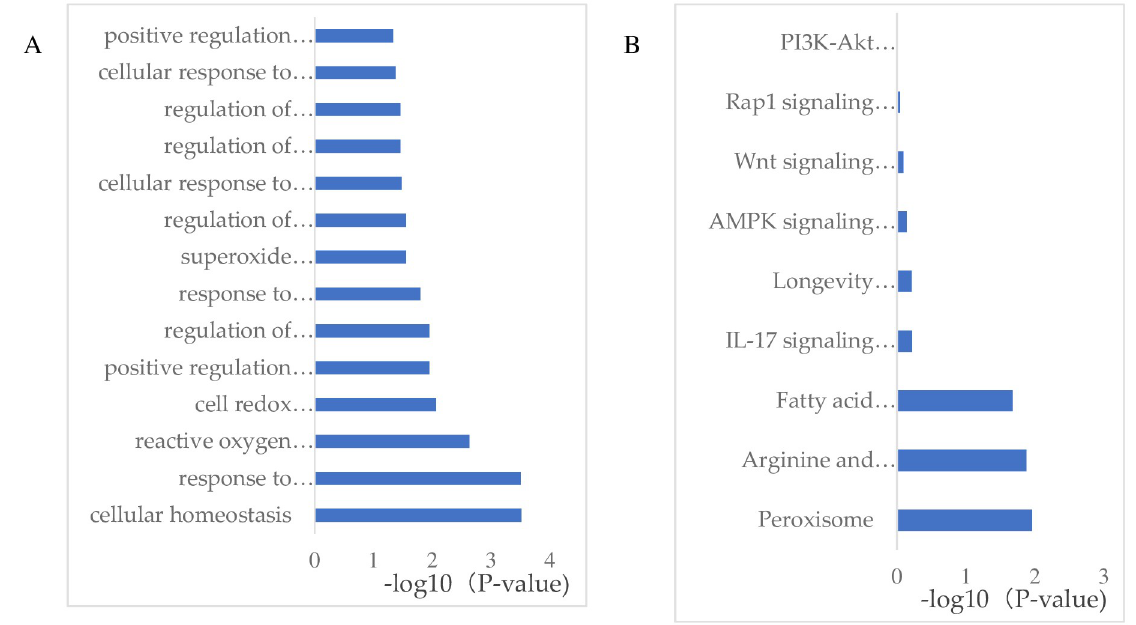
Fig 4. GO and KEGG Pathway enrichment analysis of the DEGs. (A) GO enrichment analysis, the Y coordinate in the fig is the GO item name, and the X coordinate is the -log10 (P-value). (B) KEGG enrichment analysis, the Y axis in the fig is the Pathway name, and the X coordinate is the -log10